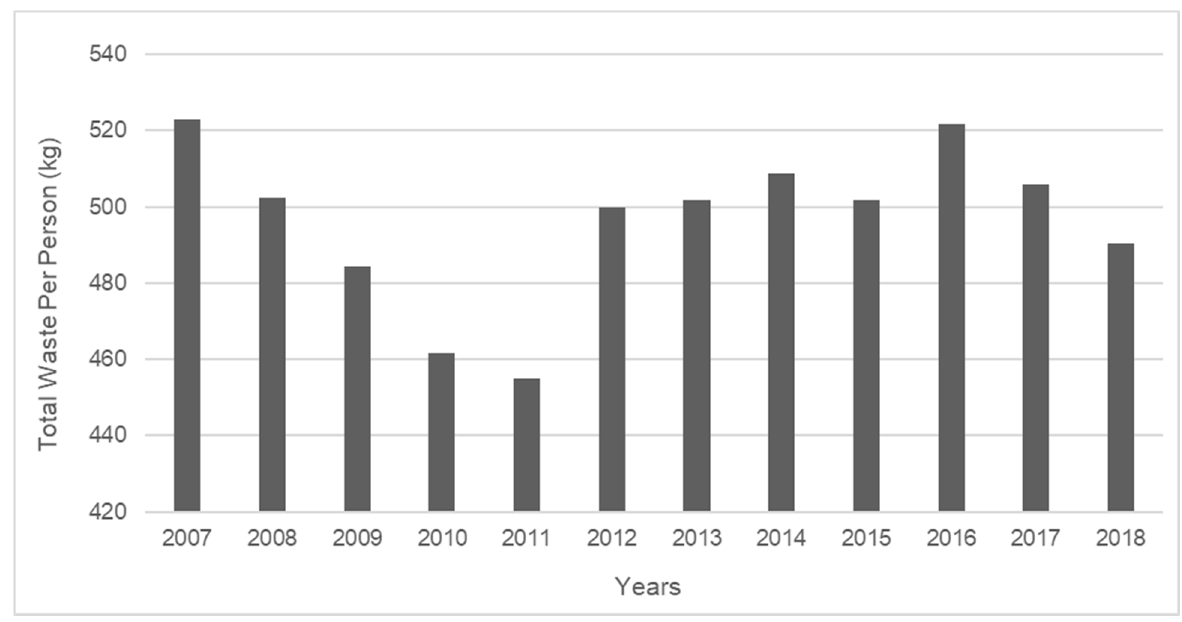
Figure 1. Total yearly municipal waste produced per person (kg); Welsh average. Source: WasteDataFlow and StatsWales.